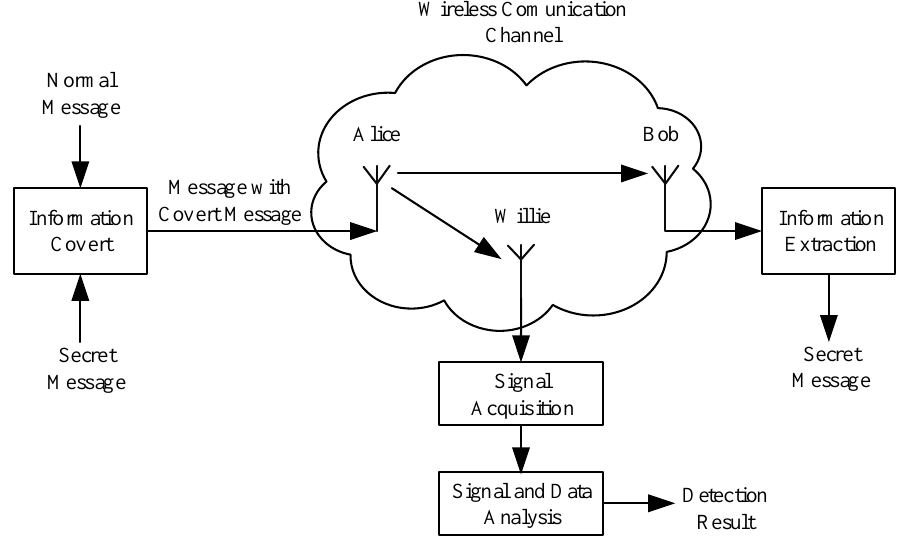
Figure 1. The framework of wireless covert